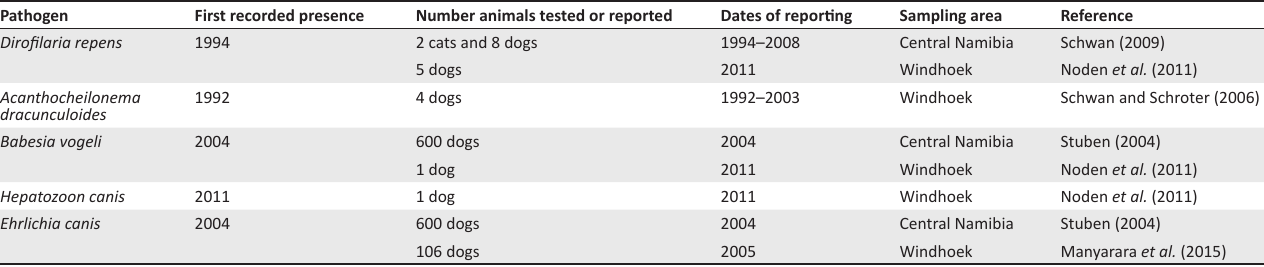
TABLE 1: Published records of vector-borne diseases of companion dogs and cats in Namibia.